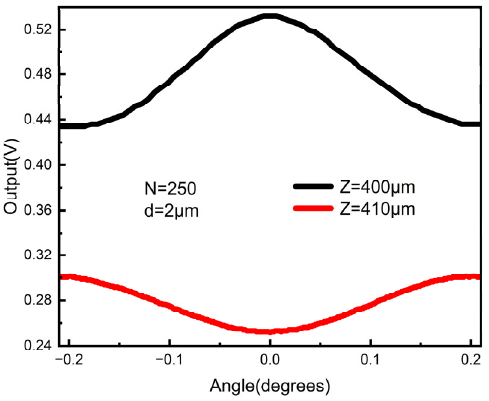
Figure 9. The output of the photodetector at Z = 400 μ m and 410 μ m, respectively.